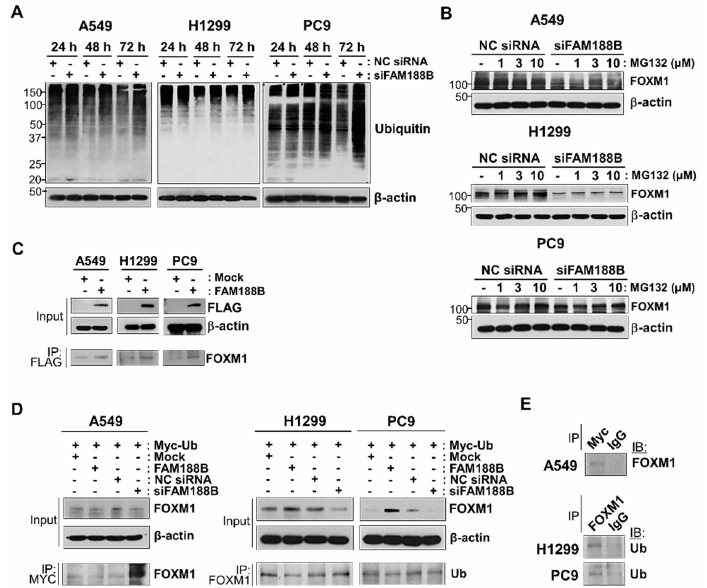
Figure 5. Effects of FAM188B on ubiquitination levels of both total proteins and FOXM1. ( A ) Total protein ubiquitination by FAM188B knockdown. A549, H1299, and PC9 cells were transfected either